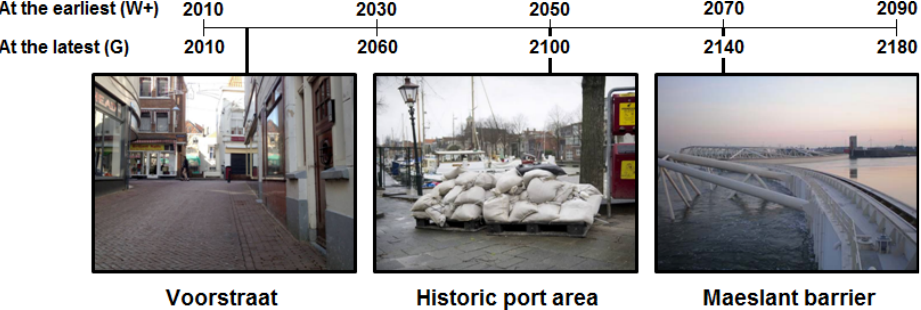
Fig. 4. Timing of the critical ATPs for flood risk management of the Island of